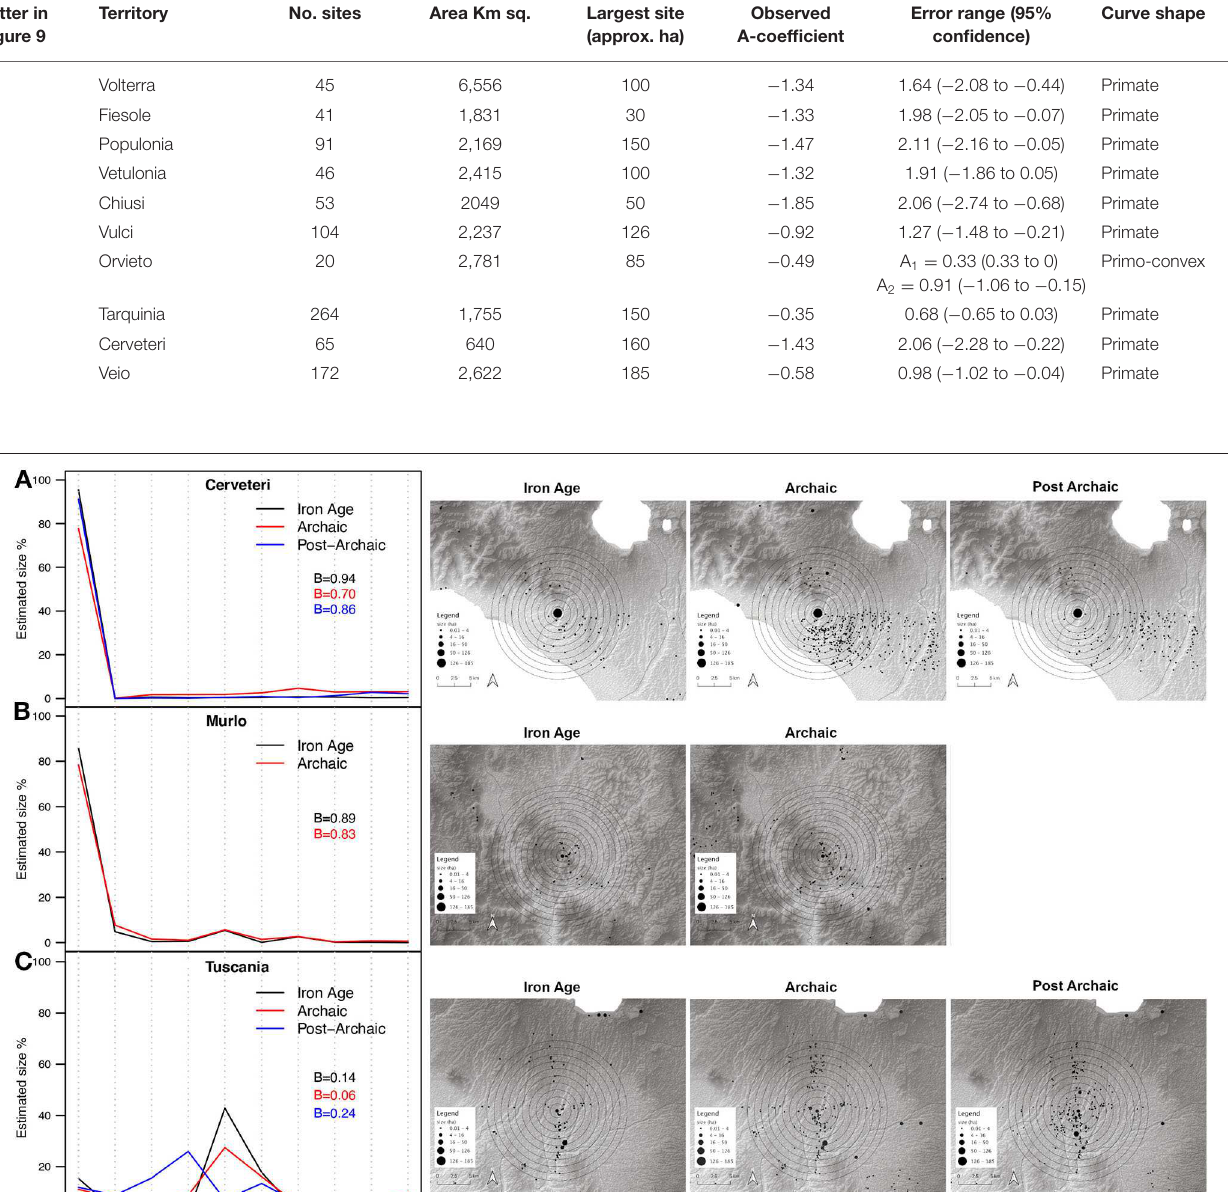
TABLE 5 | A-coefficient values and bootstrapped error ranges for log scale rank-size curves of the XTENT-defined territories in Etruria in the Post-Archaic period. Letter in Territory No. sites Area Km sq. Largest site Figure 9